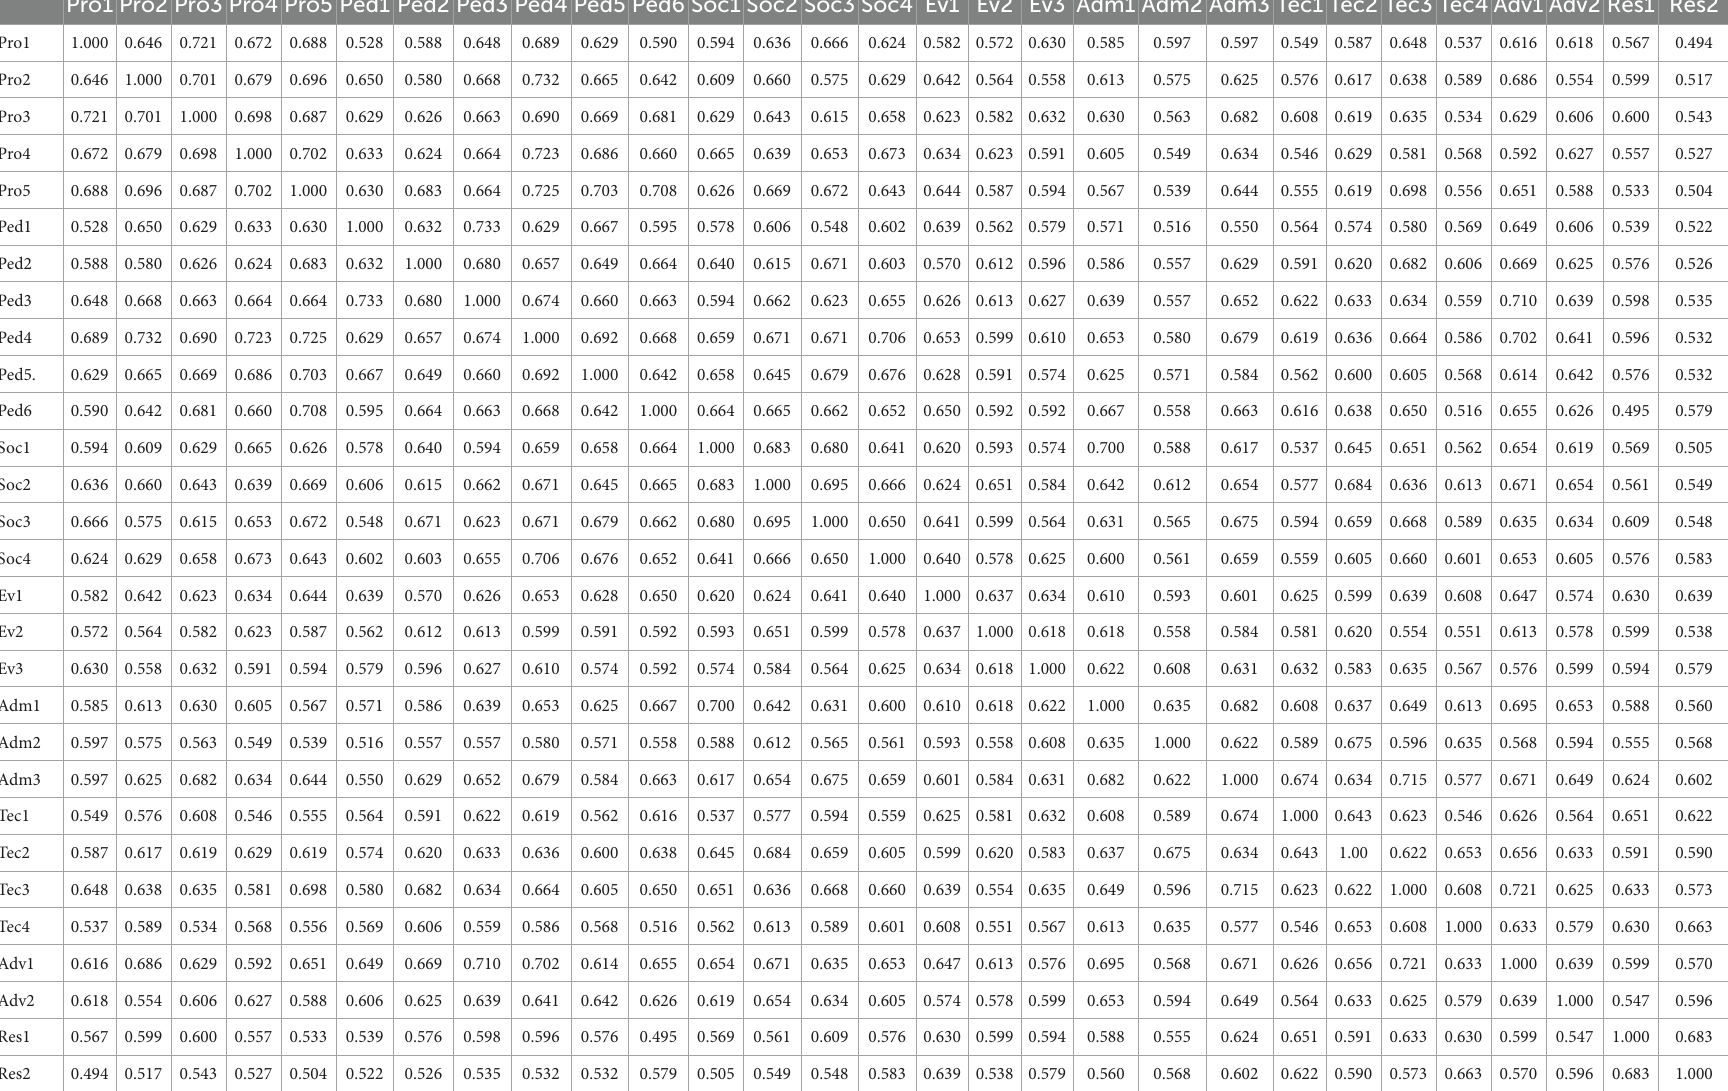
TABLE 6 Correlation between categories items. Pro1 Pro2 Pro3 Pro4 Pro5 Ped1 Ped2 Ped3 Ped4 Ped5 Ped6 Soc1 Soc2 Soc3 Soc4 Ev1 Ev2 Ev3 Adm1 Adm2 Adm3 Tec1 Tec2 Tec3 Tec4 Adv1 Adv2 Res1